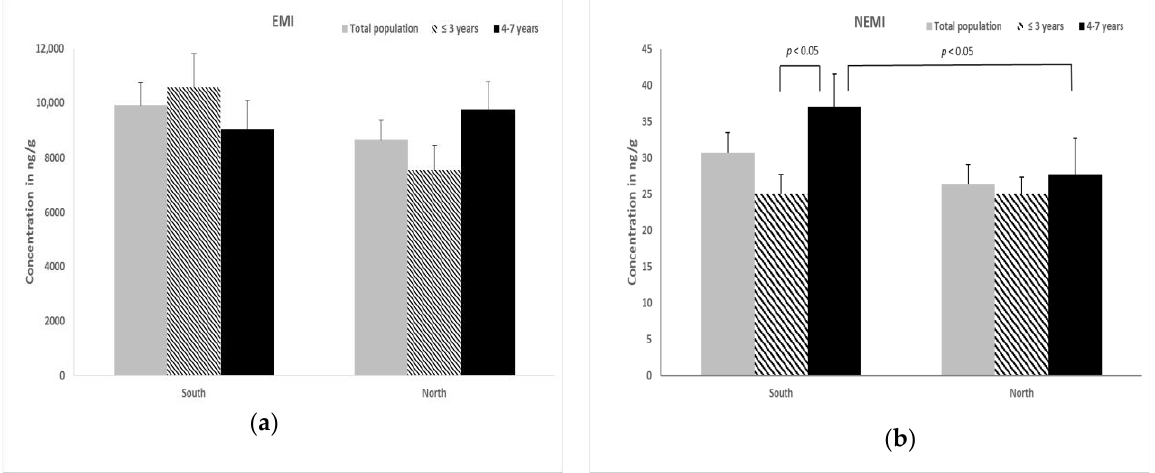
Figure 2. The mean ± SEM of ( a ) the essential metal index (EMI) and of ( b ) the non-essential metal index (NEMI) in ovarian tissues of free ranging bitches of different groups.